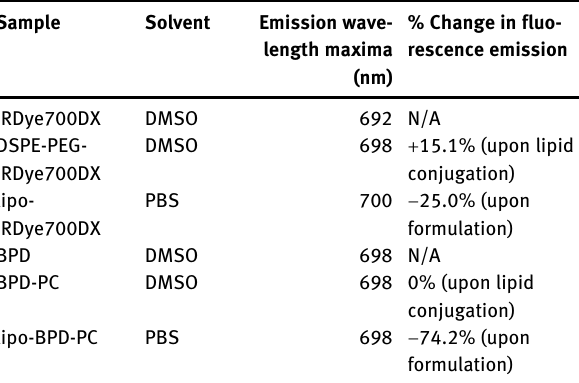
Table  : Fluorescence emission properties of each PS in its native form, when conjugated to its respective lipid, and when formulated into